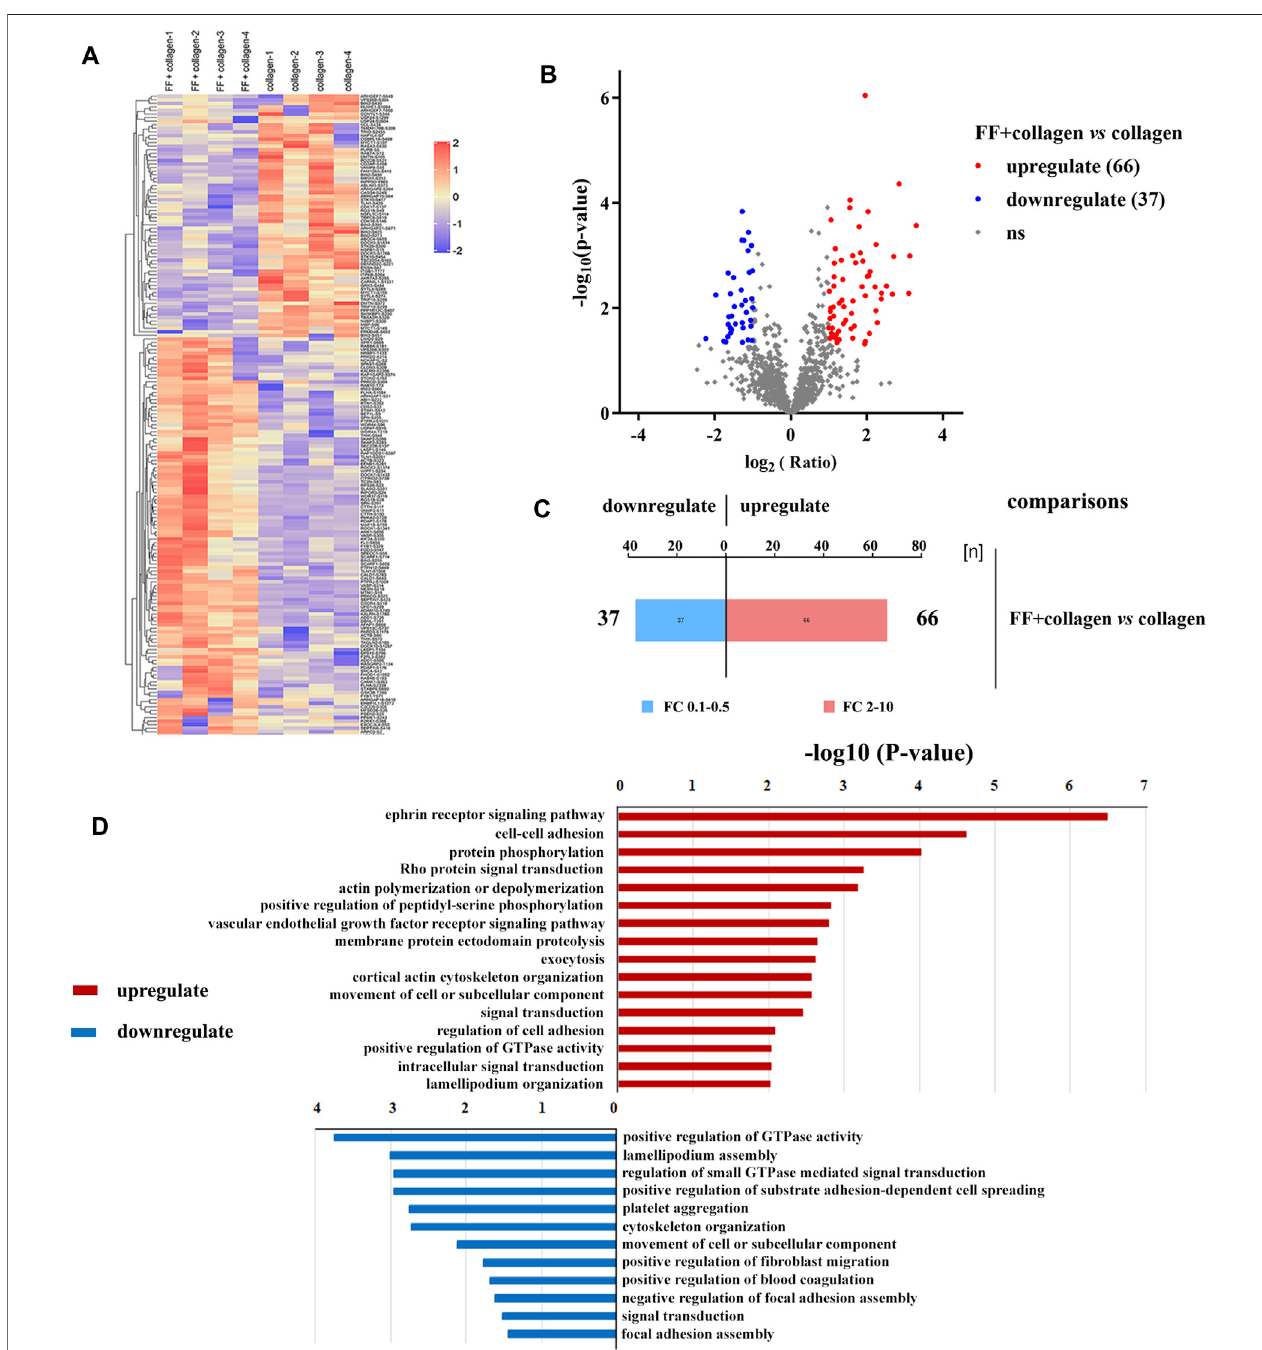
FIGURE 3 | Quantitative phosphoproteomics analysis of collagen-stimulated platelets with and without FF treatment. (A) Heatmap of different protein phosphorylation pro fi les with and without FF treatment in collagen-stimulated platelets. (B) Volcano map that shows 66 upregulated and 37 downregulated phosphopeptideswithandwithoutFFtreatment,respectively,incollagen-stimulatedplatelets. (C) Histogramofmultiplecorrelationsofcollagen-stimulatedplateletswith andwithoutFFtreatment. (D) Biologicalprocessesidenti fi edbyGeneOntologyenrichmentanalysisofcollagen-stimulatedplateletswithandwithoutFFtreatment.